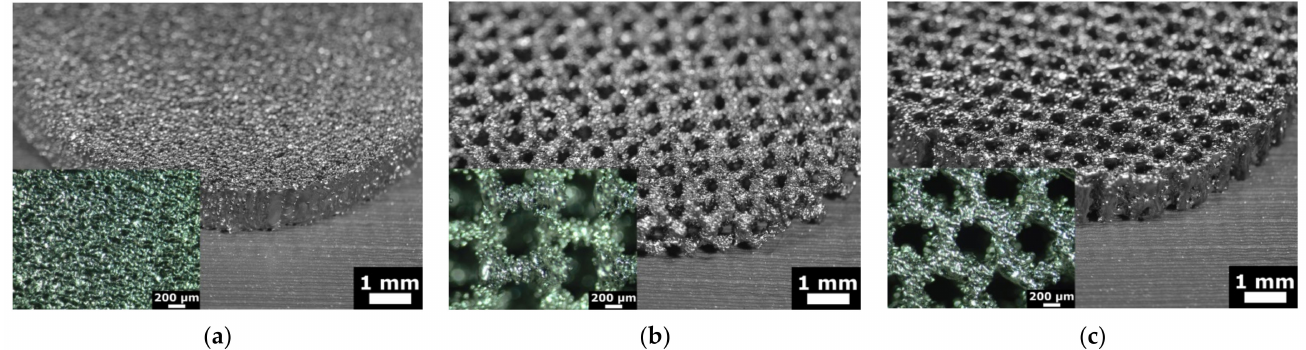
Figure 5. Microscopy images of Ti-disks fabricated using 3D additive manufacturing technique: ( a ) solid, ( b ) wurtzite and ( c ) honeycomb. Disks have the diameter of 15 mm and are 2 mm thick.